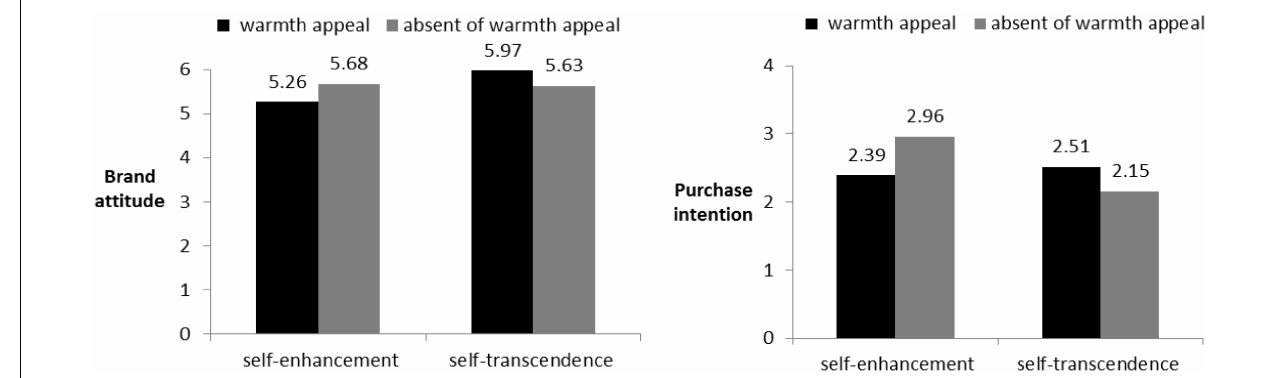
FIGURE 3 | Brand attitude and purchase intention in Experiment